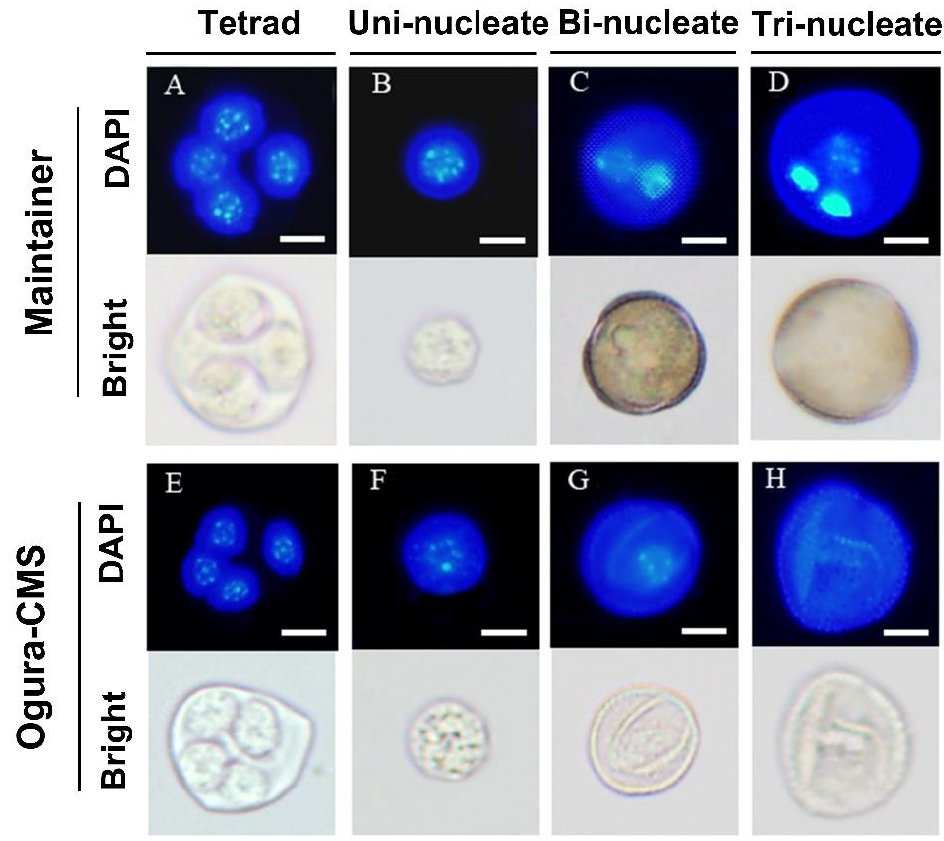
Figure 2. DAPI staining of microspore development process of the Ogura CMS line (Tyms) and the maintainer line (231–330) in Chinese cabbage. ( A – D ) DAPI-stained developing spores from the maintainer line (231–330); ( E – H ) DAPI-stained developing spores from the Ogura CMS line (Tyms). ( A , E ): Tetrad; ( B , F ): Uni-nucleate; ( C , G ): Bi-nucleate; ( D , H ): Tri-nucleate; Bar = 50 μm.